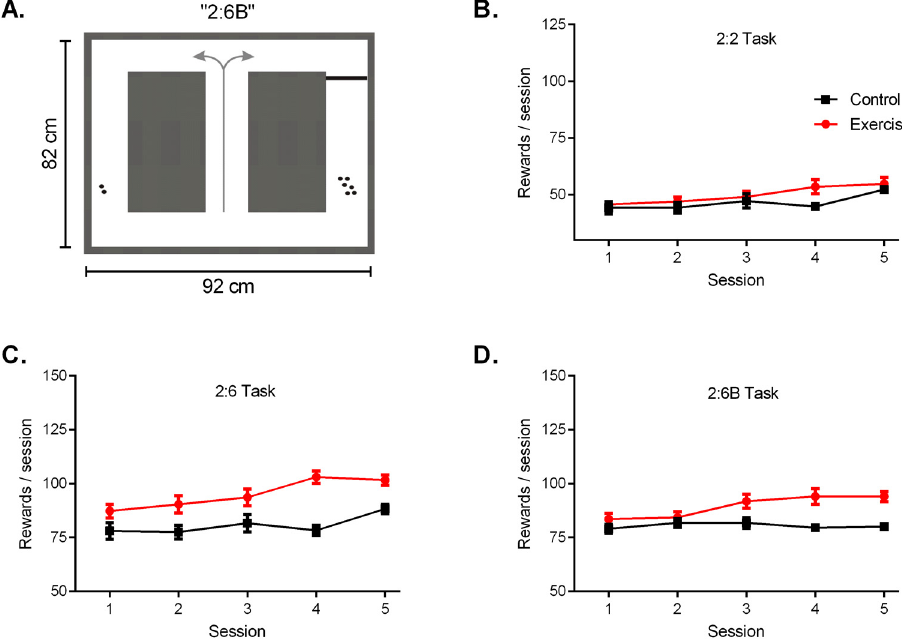
Fig 3. Maze Tasks. A) Schematic of the continuous T-maze, illustrating the 2:6B configuration. On each trial, the rat would run up the mid-stem (indicated by arrows) and proceed down the left or right arm. Each arm was baited with food pellets (indicated by dots), in either a 2:2 or 2:6 ratio. A bold line indicates where a climbing barrier was placed to create the 2:6B configuration. B) When given 5 min in the 2:2 configuration, there was no difference between groups in reward gain across sessions. C) When given 20 trials in the 2:6 configuration, the Exercise group selected the HR option more often than Controls, resulting in greater reward gain. D) When given 20 trials in the 2:6B configuration, the Exercise group selected the HEHR option more often than the Controls in the later sessions, resulting in greater reward gain. Data are shown as mean ± SEM; for each group n =